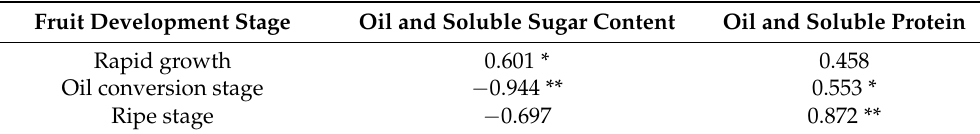
Table 2. Correlation analysis of seed oil with soluble sugar and protein at different stages of fruit development. Fruit Development Stage Oil and Soluble Sugar Content Oil and Soluble Protein Rapid growth 0.601 * 0.458 Oil conversion stage 0.553